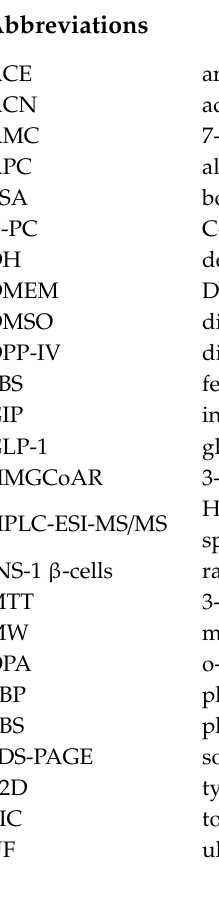
Table S1: HPLC-Chip-ESI-MS / MS based identification of peptides in the tryptic PBP hydrolysate. Figure S1: SDS-PAGE of purified PBP and total spirulina protein